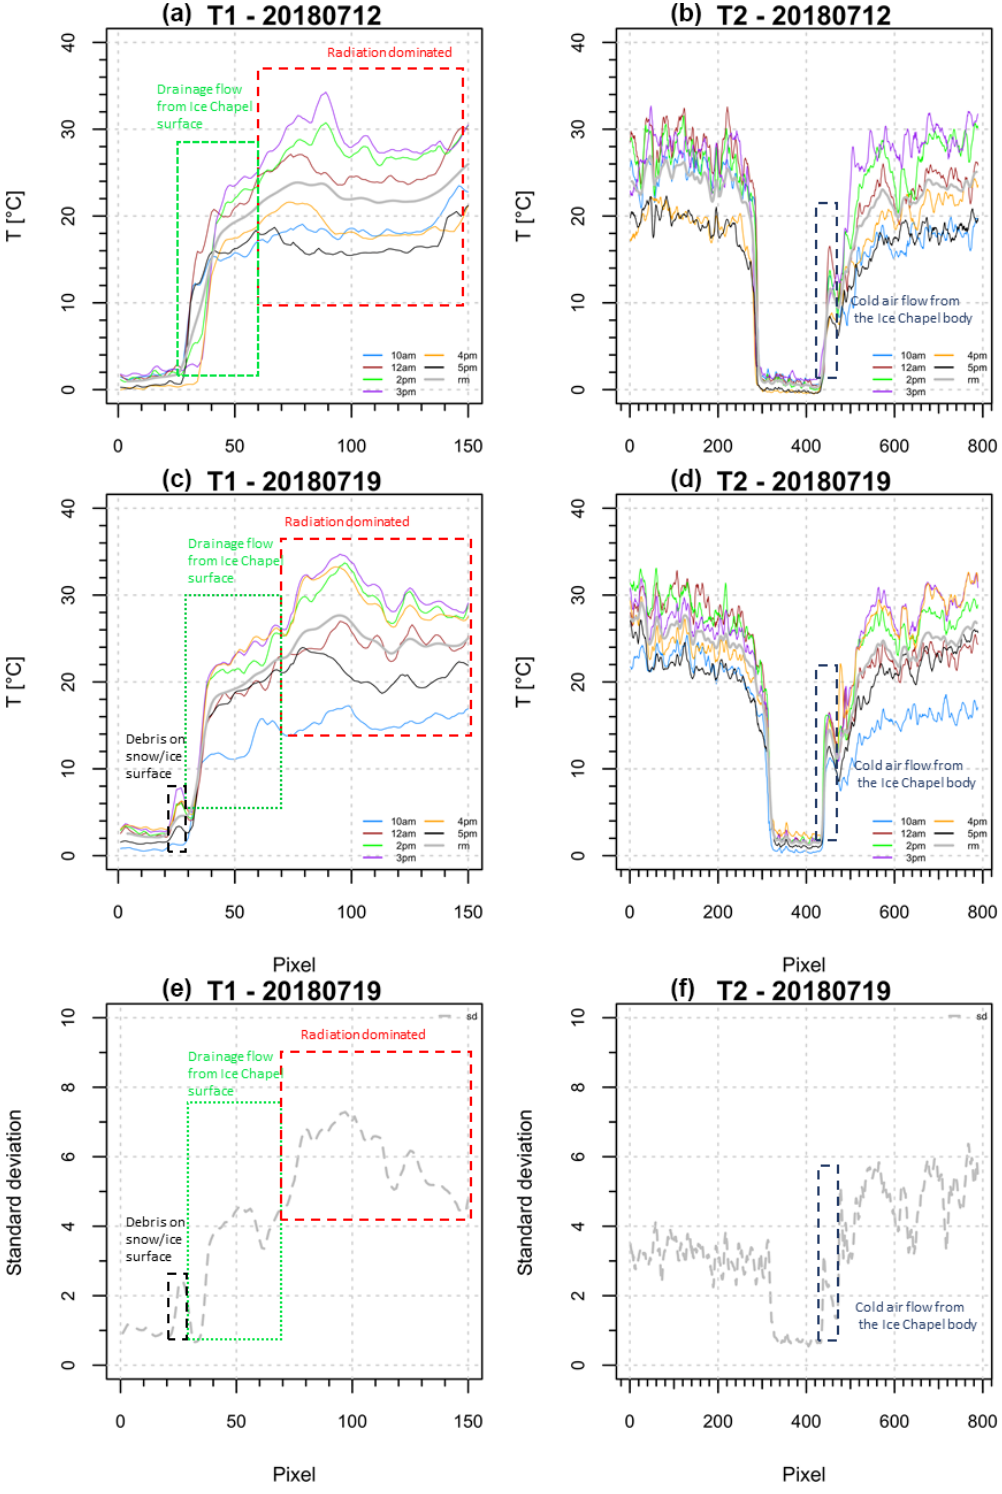
Figure 10. Transect lines showing surface temperatures along the moraine slopes measured on 19 July 2018 at 10:00, 12:00, 14:00, 16:00, and 17:00 for two measurement days and at two different locations (a–d) , shown in Fig. 7b. Standard deviation of T S measured at different points in time is presented in (e) and (f)